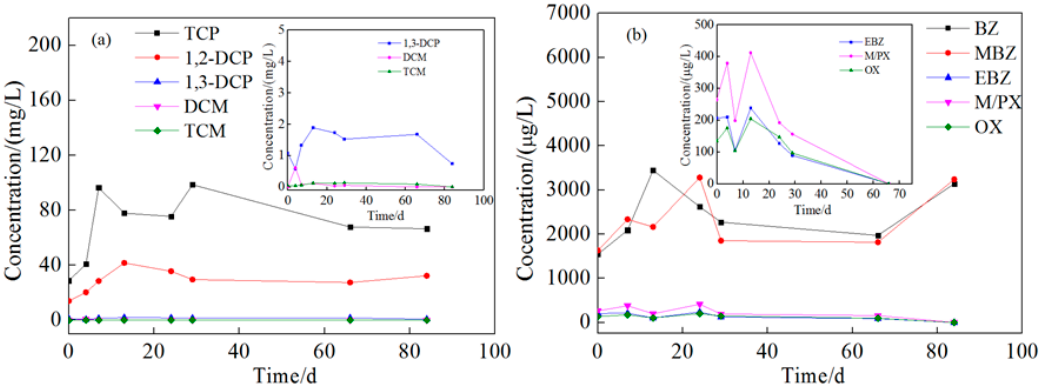
Figure 9. Concentration change of pollutants at deep injection well. Ordinate: ( a ) The concentration of chlorinated hydrocarbons; ( b ) the concentration of BTEX. Inset: ( a ) Amplified concentration change curves of 1,3-DCP, DCM and TCM; ( b ) amplified concentration change curves of EBZ, M/PX, and OX.